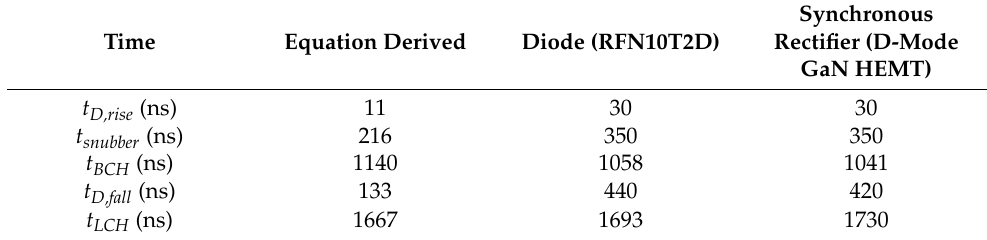
Table 10. Parameter of the proposed converter.